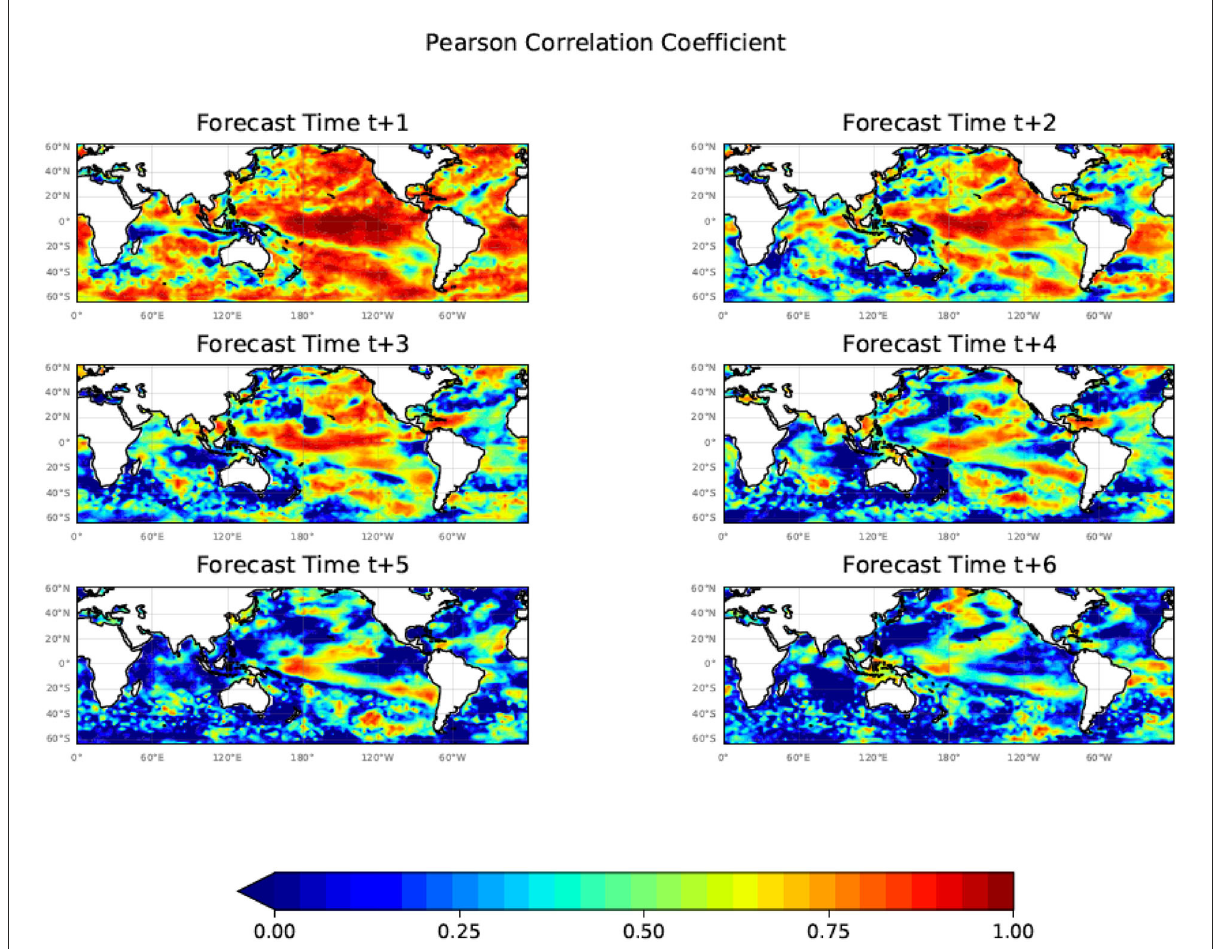
FIGURE9 The Pearson correlation coefficient (R) calculated using the 10 24-month forecasts commencing each July from July 2006 until July 2015 for months t+1 to t+6 showing large regions of significant correlation between the model predicted and ERA5 SST values out to t+6. In order to use a 10-year period, part of the data for the correlation analysis is from the training period, however, the case studies in the model validation period of the study tend to support the correlation